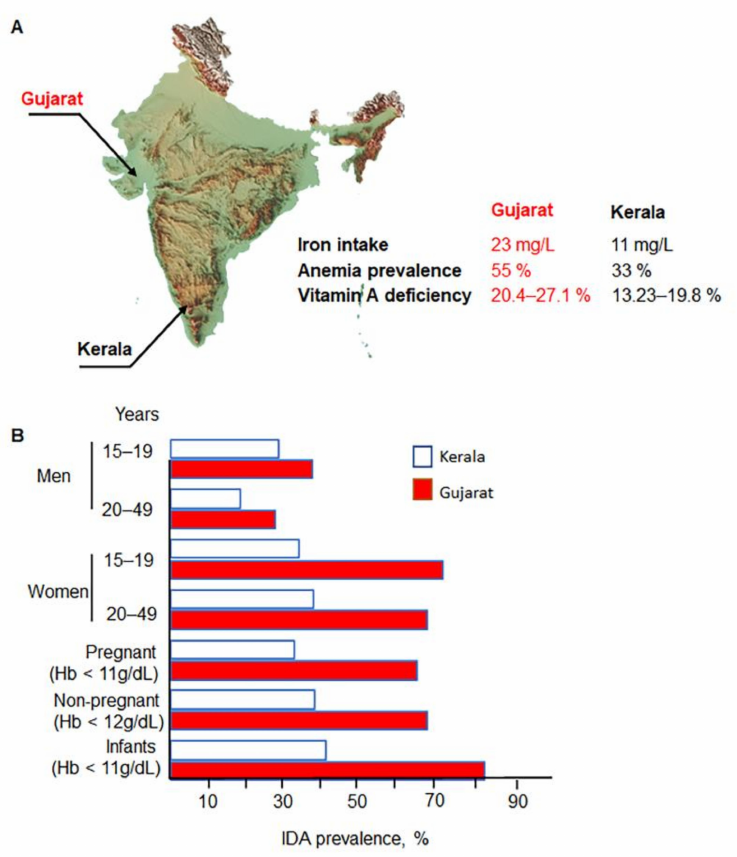
Figure 1. Prevalence of IDA is higher in Gujarat compared to Kerala despite higher iron intake in Gujarat state. ( A ) Gujarat has a higher prevalence of vitamin A deficiency than Kerala. Kerala presents a lower iron intake than Gujarat. ( B ) Prevalence of IDA in Gujarat in all population subsets compared to Kerala. Data are from 2019–2021